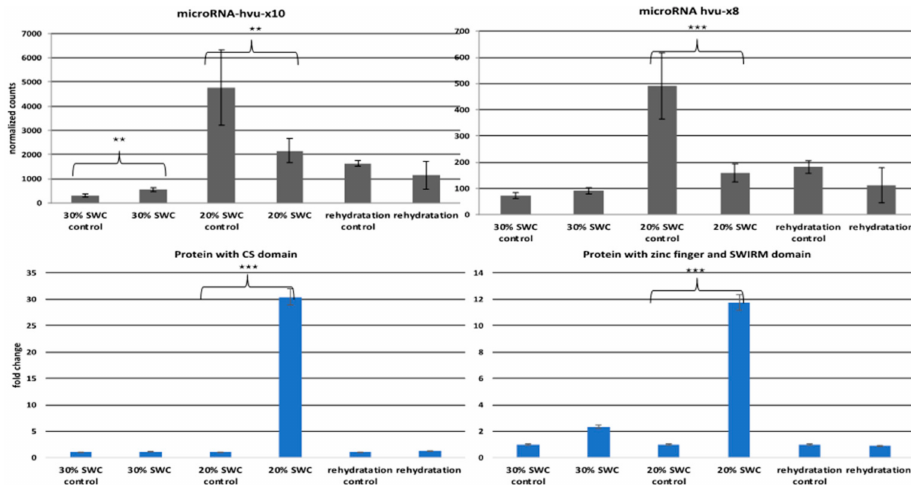
Figure 7. Expression analysis of novel barley microRNAs and their target genes in drought conditions (30% SWC, 20% SWC and rehydratation). Grey graphs show the level of particular microRNA based on normalized counts from sRNA libraries (OY axes points to normalized counts from sRNA libraries while OX axes point to control and di ff erent stress conditions). Names of particular microRNAs are provided above the graphs. Panels below depict blue graphs that show expression of target genes for particular microRNAs using RT-qPCR with primers flanking microRNA-recognition site (OY axes represent fold change and OX point to control and di ff erent stress conditions) ** p -value ≤ 0.01, *** p -value ≤